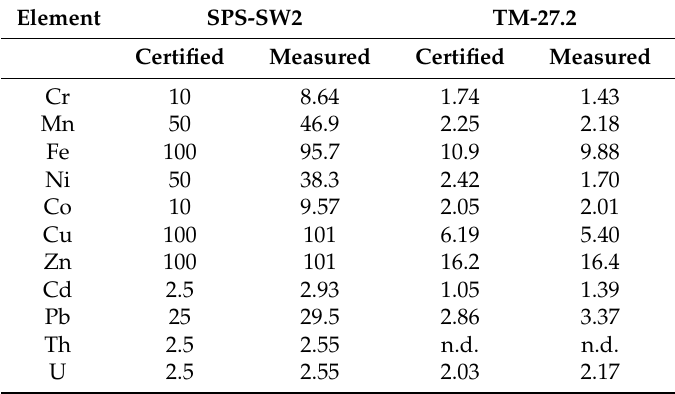
Table 2. Certified and measured concentration values (ppb) of the studied metals in two reference waters SPS-SW2 and TM-27.3. Measured values are means of triplicates. n.d. = not